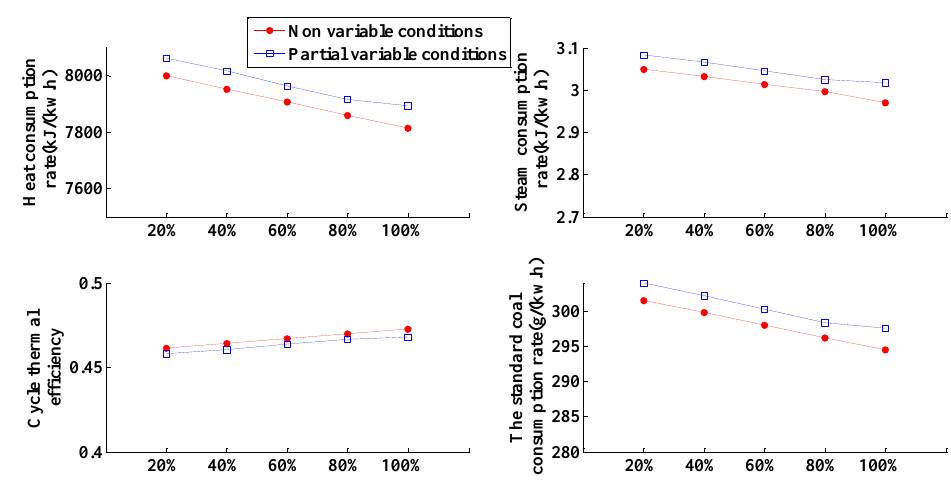
Figure 12. SAPG system 3rd thermal economy.